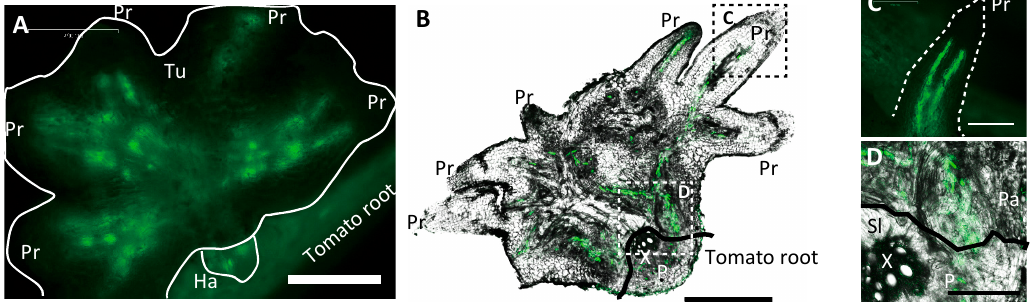
Figure 2. Translocation of green fluorescent protein (GFP, green) from AtSUC2::GFP tomato roots to a tubercle. ( A ) GFP in a 3-mm-diameter tubercle. Scale bar: 500 μ m. ( B ) GFP detected by immunostaining in a paraffin section of a 3-mm-diameter tubercle. Scale bar: 250 μ m. ( C ) Magnified image of the rectangle C in Panel (B). GFP in a protrusion. Scale bar: 100 μ m. ( D ) Magnified image of the rectangle D in Panel (B). GFP in the tomato- Phelipanche aegyptiaca interface. Scale bar: 100 μ m. Tu, tubercle; Ha, haustorium; Pr, protrusion; X, xylem of tomato; P, phloem of tomato; Sl, tomato; Pa, P. aegyptiaca .